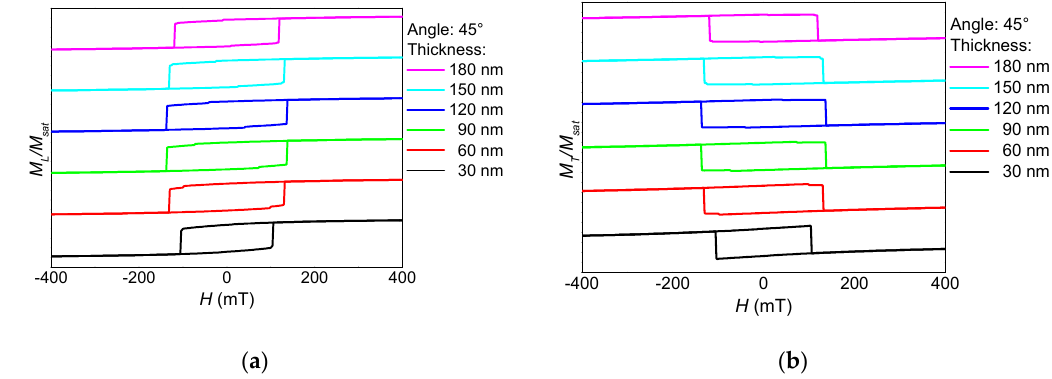
Figure 7. Thickness dependence of ( a ) the longitudinal and ( b ) the transverse hysteresis loops, simulated for sample NF2 under an angle of 45°.